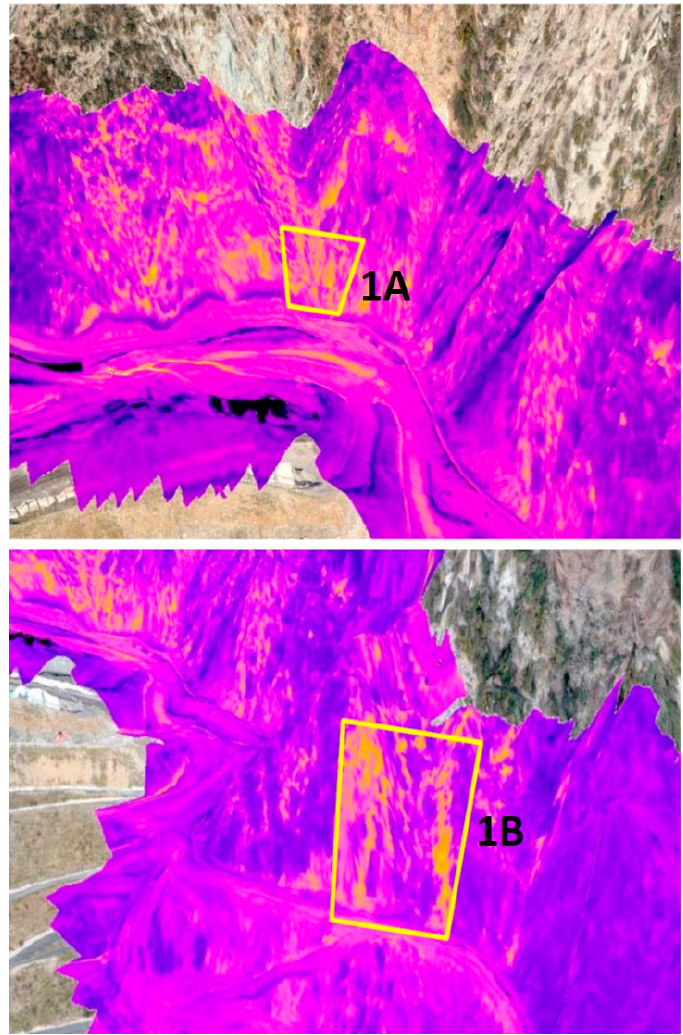
Figure 4. Three-dimensional mosaic images of some areas of the landfill (Mount Scarpino); zones with marked thermal anomalies (1A and 1B) are highlighted. Table 1. Estimated methane flow rates and main parameters included in the calculation procedure. Region